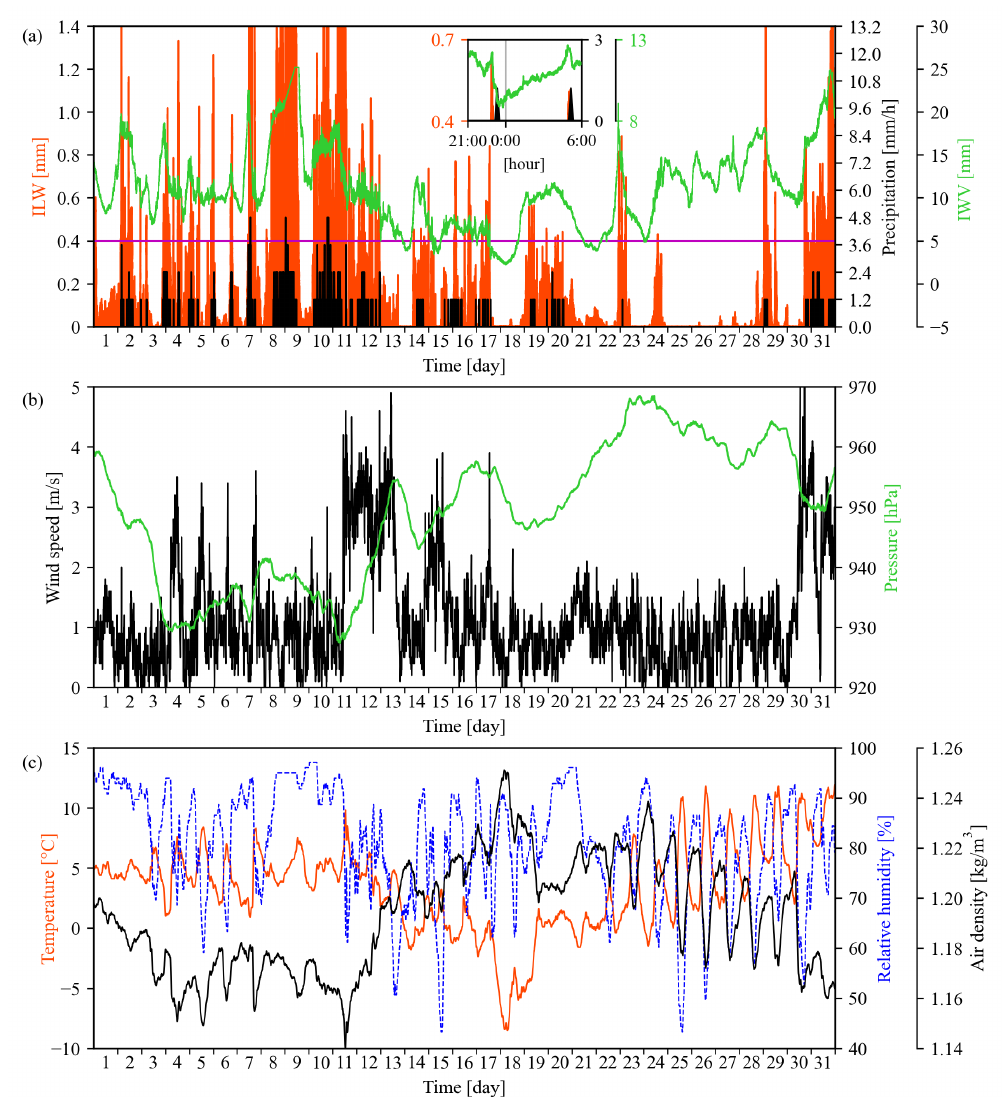
Figure 7. Time series of TROWARA and meteorological data from 1–31 January 2016. ( a ) Time series of IWV (green solid line), ILW (red area), and the precipitation (black area). The purple horizontal line is ILW = 0.4 mm. The subplot is from 21:00 UT on 2 January to 6:00 UT on 3 January. ( b ) Time series of surface pressure (green solid line) and wind speed (black solid line). ( c ) Time series of surface temperature (red solid line), relative humidity (blue dashed line), and air density (black solid